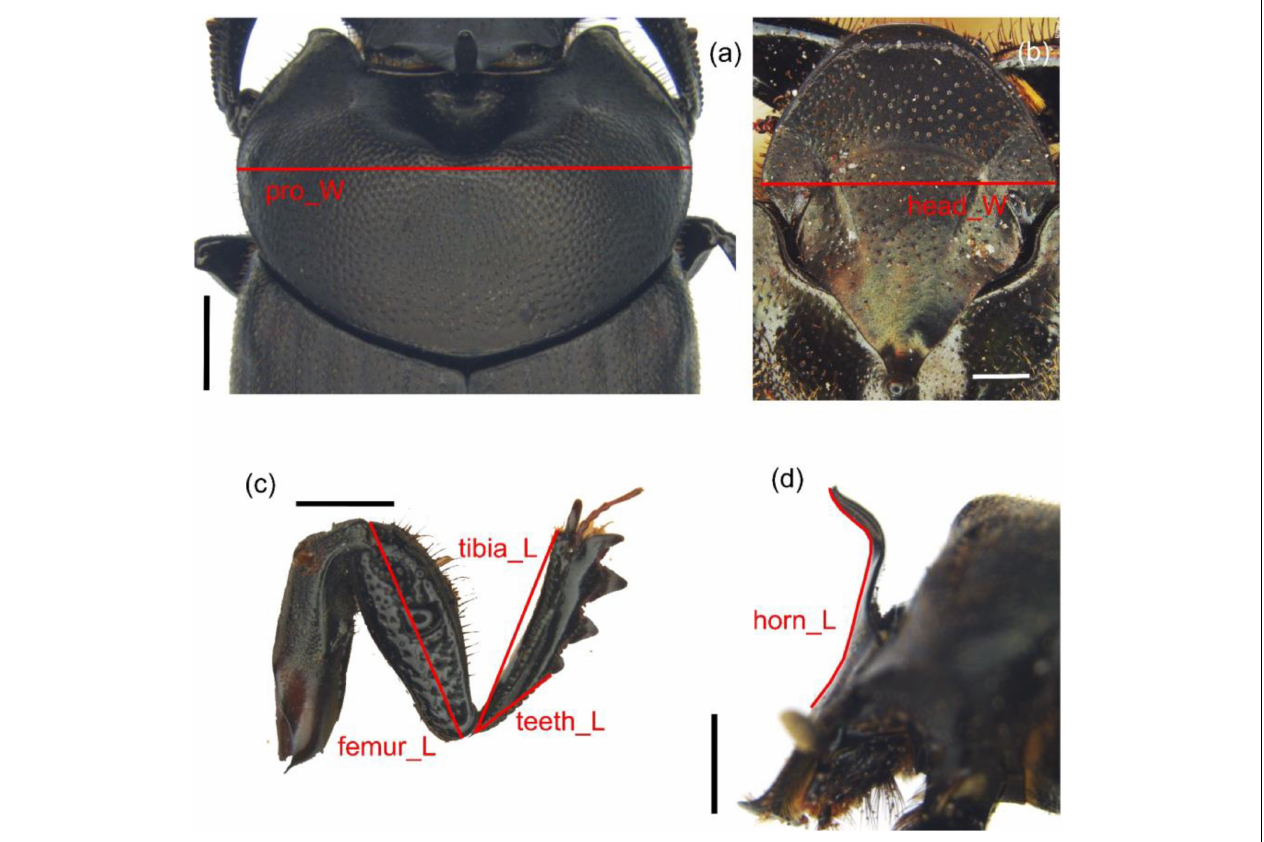
FIGURE 1 | Measurements of the various morphological traits: (a) pronotum width, (b) head width (above), (c) left foreleg with tibia length, femur length, and teeth length, and (d) head with horn length (side view) of O. verticicornis . Scale bar = 1 mm for (a,c,d) ; scale bar = 0.5 mm for (b)